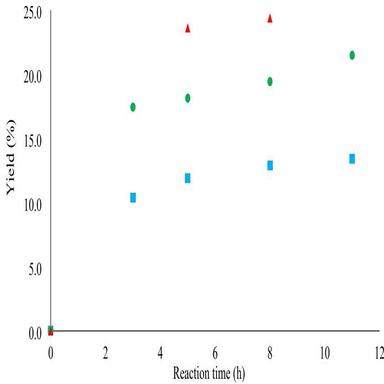
Yield estimated by GPC analysis using different molecular weight dextran at a 1:1 wt. ratio with BSA. Experiments conducted in solid state using Process A and C, after lyophilization at pH 7.8. Red triangle - dextran (10 kDa, Process A), green circle – dextran (40 kDa, Process C), blue square - dextran (40 kDa, Process A).